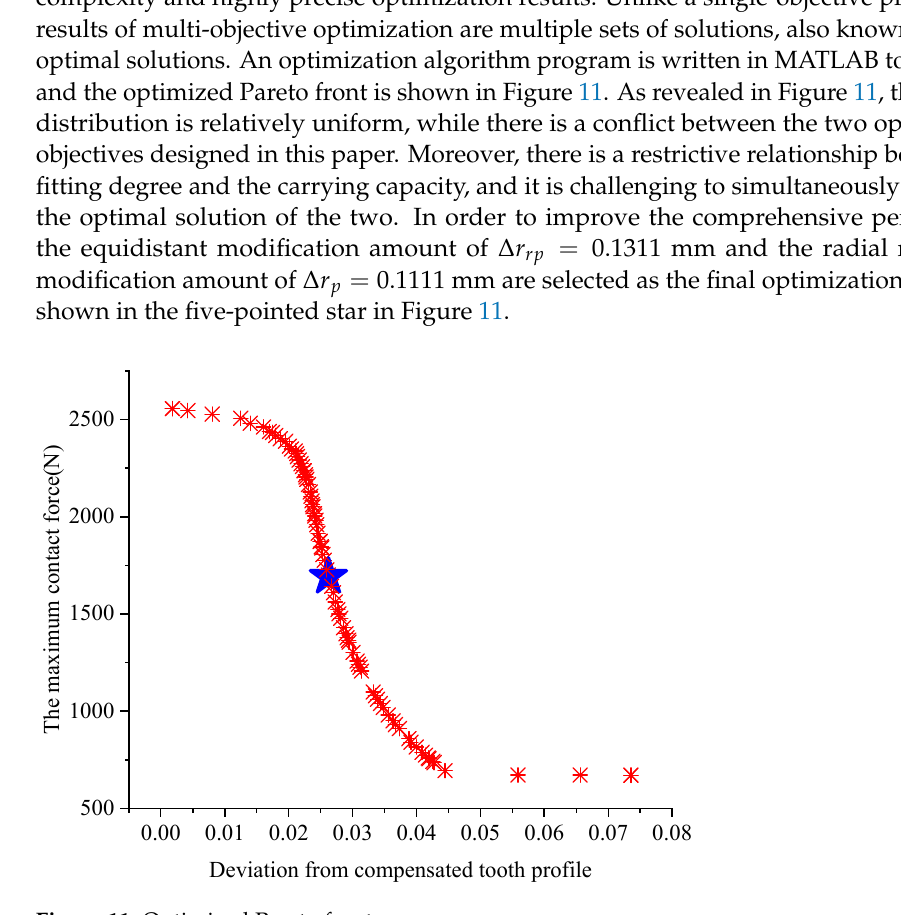
Figure 11. Optimized Pareto front.